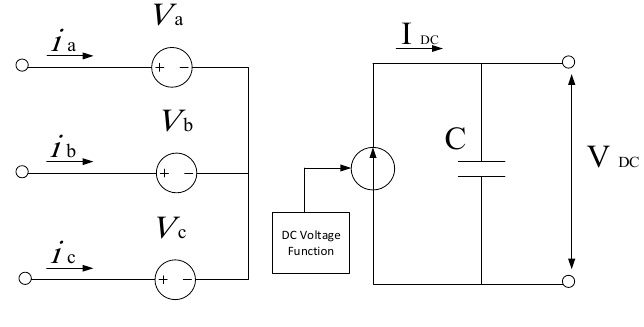
Figure 12. Averaged model of VSC. I DC